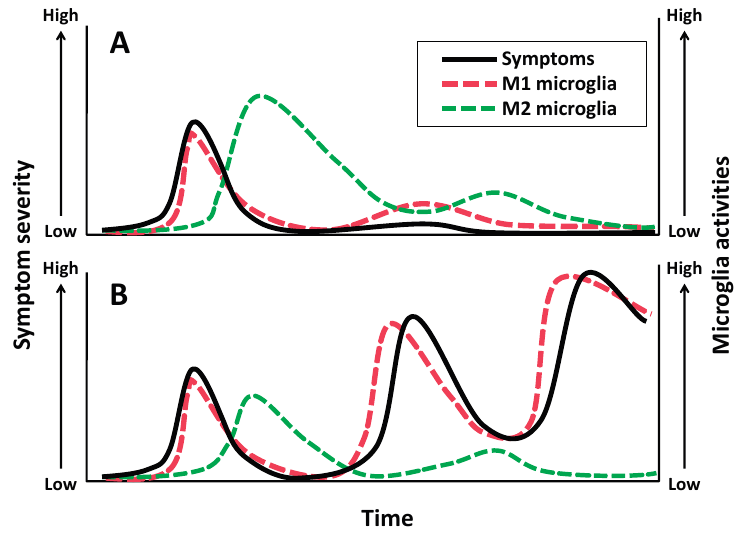
Figure 2. Hypothetical model of relationship between M1/M2 microglia activities and symptom severity in schizophrenia. ( A ) In the early stage of schizophrenia, symptoms may be followed by microglial M1 polarization which is induced by neuronal hyperactivation in insula, inferior frontal gyrus, and hippocampus, possible initiating brain regions of the disorder. M1 microglia can produce pro-inflammatory cytokines and remove the damaged nerve fibers by phagocytosis, whereas M2 microglia down-regulate M1 microglial function and restore tissue homeostasis with consequent attenuation of symptoms. ( B ) If M2 polarization of microglia is insufficient, M1 microglial functions are maintained and induce neural network dysfunctions continuously. Symptom severity may gradually become high according to the frequency of M1